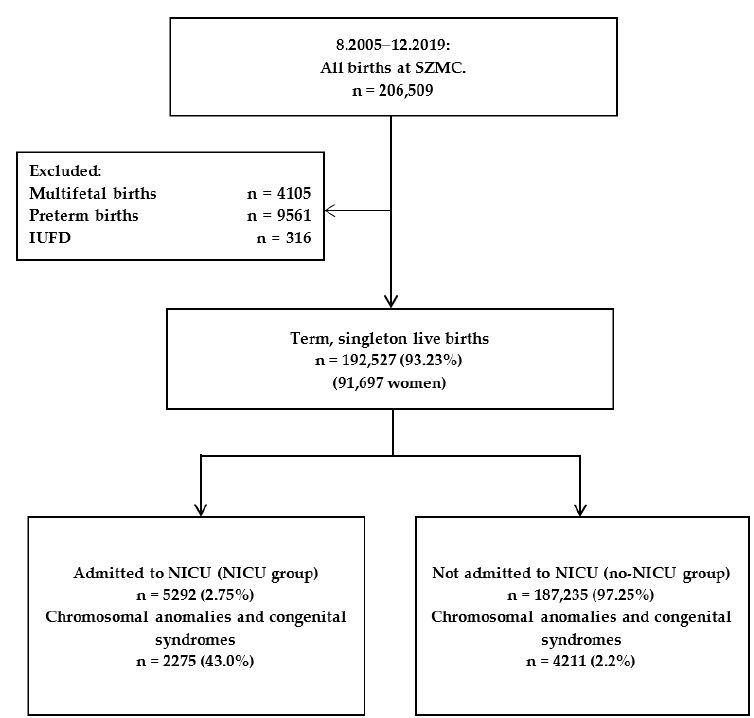
Figure 1. Study population flow diagram.